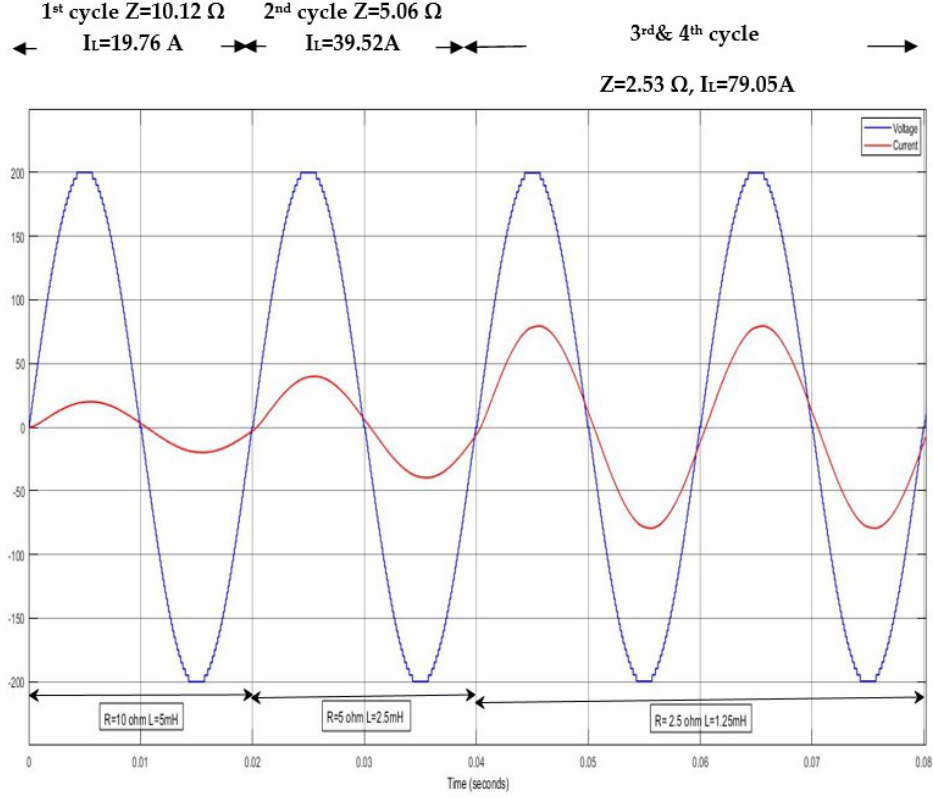
Figure 8. Output voltage and current waveforms for RL